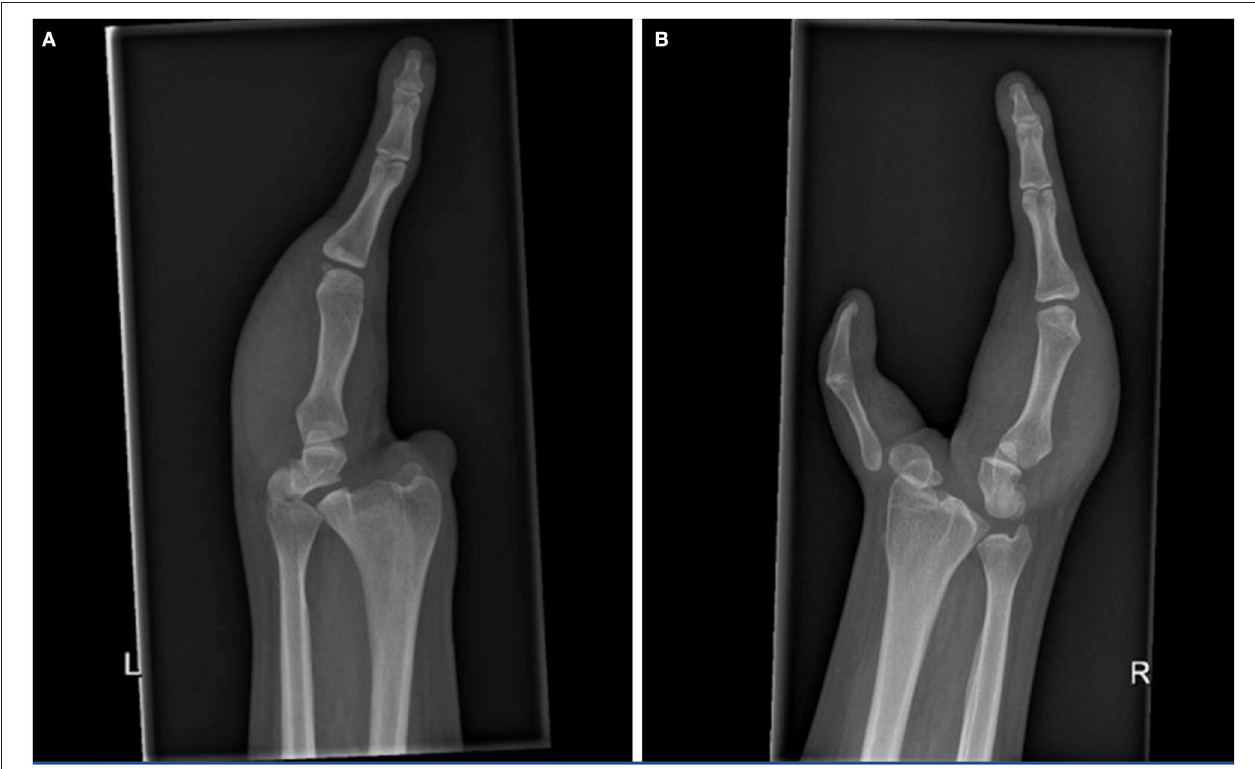
FIGURE 2 | X-rays of the left (A) and right hand (B) , show the osseous structures in this patient with cleft hands. Note the symphalangism of the right thumb bones.